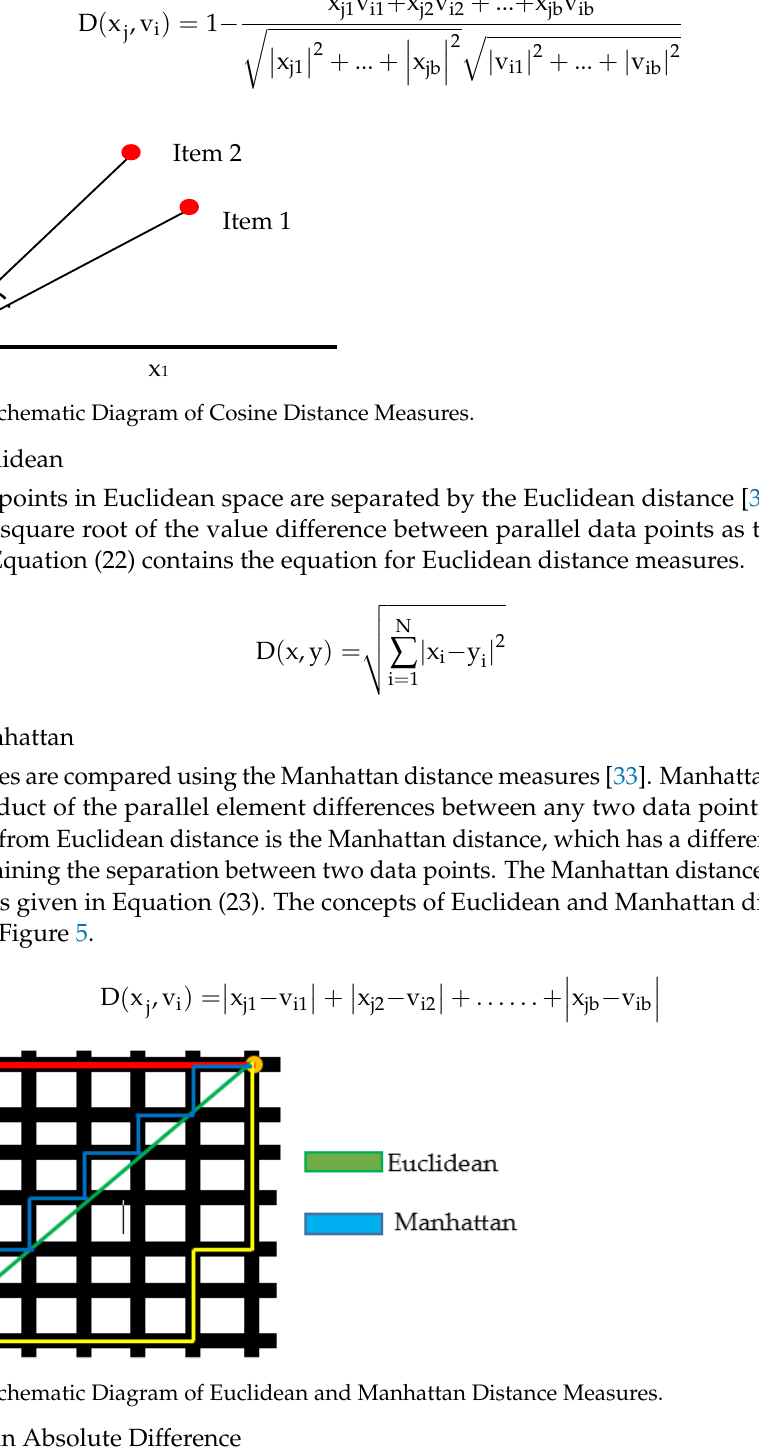
(24) Figure 6. Schematic Diagram of Mean Absolute Difference Distance Measures. 2.2.9. Median Absolute Difference To lessen the impact of impulsive noise on the derived measures, the median abso- lute difference (MAD) [35] may be used instead of the mean absolute difference. Math- ematically generally, MAD is defined as finding the difference in the absolute brightness of the comparable pixels in two images before taking the data ’ s median. Equation (25) contains the equation for MAD distance measurements. Figure 7 illustrates the idea of median absolute difference distance. j